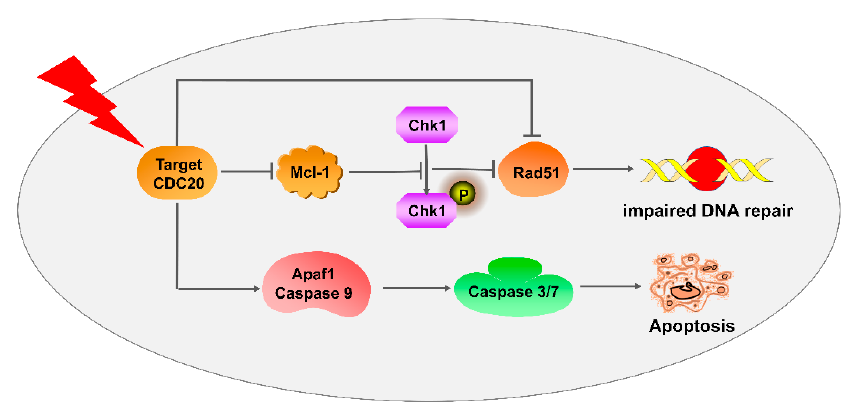
Figure 6. Schematic representation of the mechanism of CDC20-mediated radiosensitization of CRC cells.